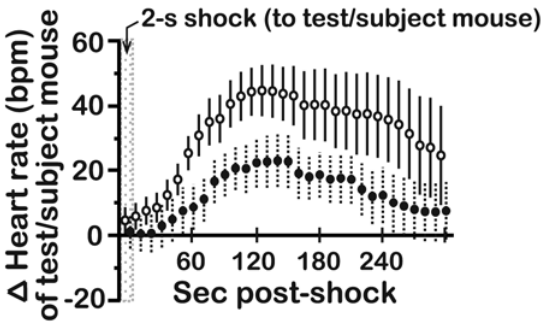
Figure 7. Heart rate changes of mice after a single exposure to the UCS. During habituation to the conditioning apparatus, HR was measured for 5 min following presentation of a single UCS. Mice from the experiments illustrated in Figures 8 and 9 were treated in the same way during the habituation period, and were therefore pooled for graphical presentation and analysis (N=24 mice/genotype; age=7– 13 wks). Each data point represents a 10-s bin. HR is presented as a change ( D ) from the baseline HR of each mouse (see Table 2). All data